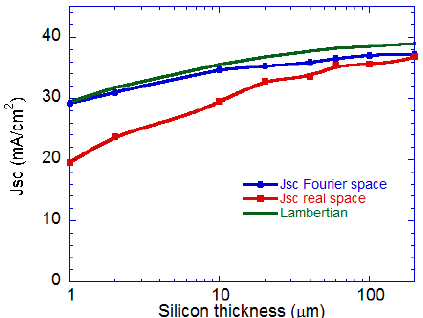
Figure 8. Comparison of the simulated short-circuit photo-current J SC as a function of the thickness of the Si absorber layer in the real-space method utilizing only the absorption in the Si layer, compared to the Fourier space method which includes the absorption in all layers. The difference between the real-space and Fourier space results is the parasitic absorption. The Lambertian limit is shown for comparison.